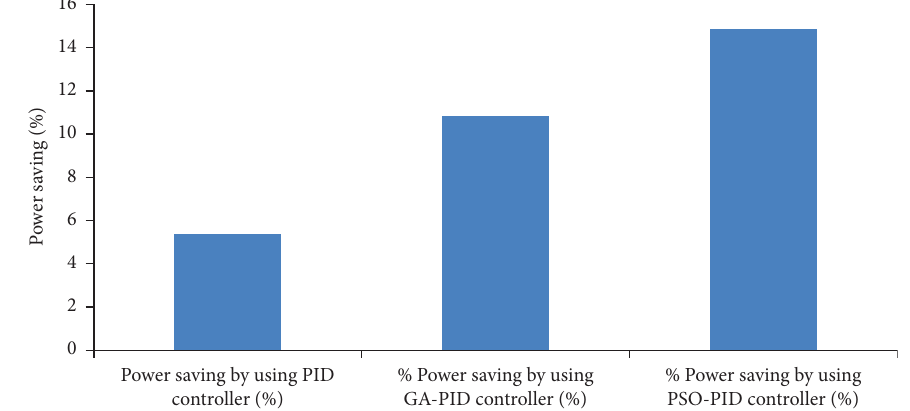
Figure 17: Power saving (%) w.r.t conventional heater.